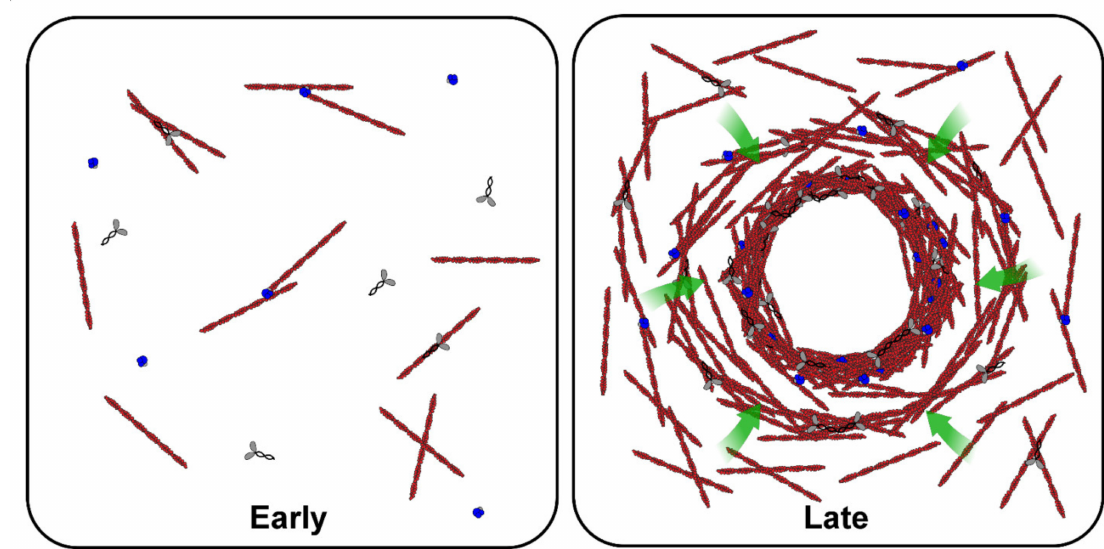
Figure 3. Gelation-contraction of the actomyosin network. Representative cartoon showing the distributions and rearrange- ments of F-actin (red), actin nucleators (blue), and myosin (gray) during early and late stages of actomyosin contraction in interphase X. laevis egg extracts. Shortly after F-actin nucleation (early stage; left panel), the F-actin network undergoes contraction (late stage; right panel), resulting in cytosolic flows towards the aggregate center (green arrows) and an F-actin density